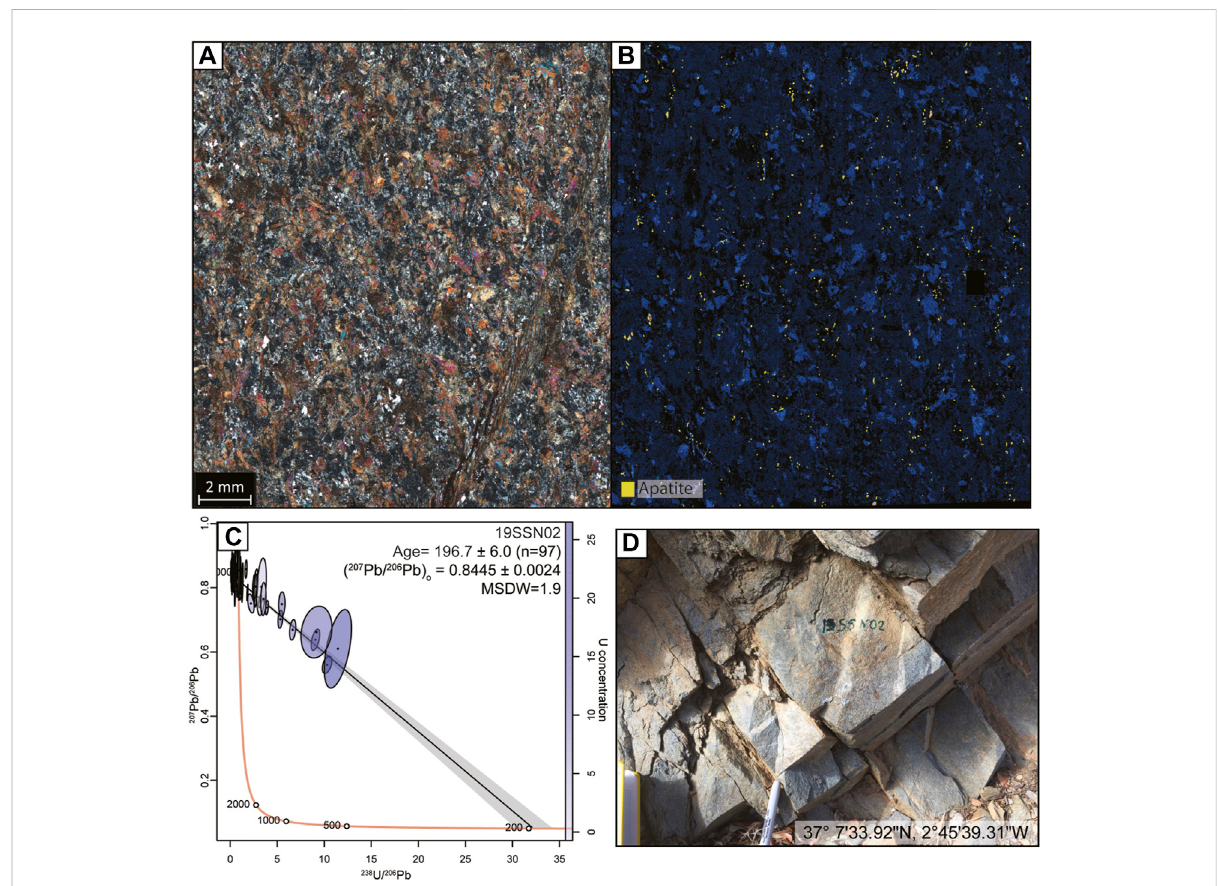
FIGURE 6 (A) Thin section scan from the metabasite (19SSN02) collected from the Veleta unit; (B) other half of the thin section scan is shown as an EDS map illustrating the presence of apatite (Phosphorus). (C) Tera-Wasserburg diagram of apatite analyses. (D) Macroscopic picture of the metabasitic outcrop with sample coordinates; the exact location is also indicated on Figure